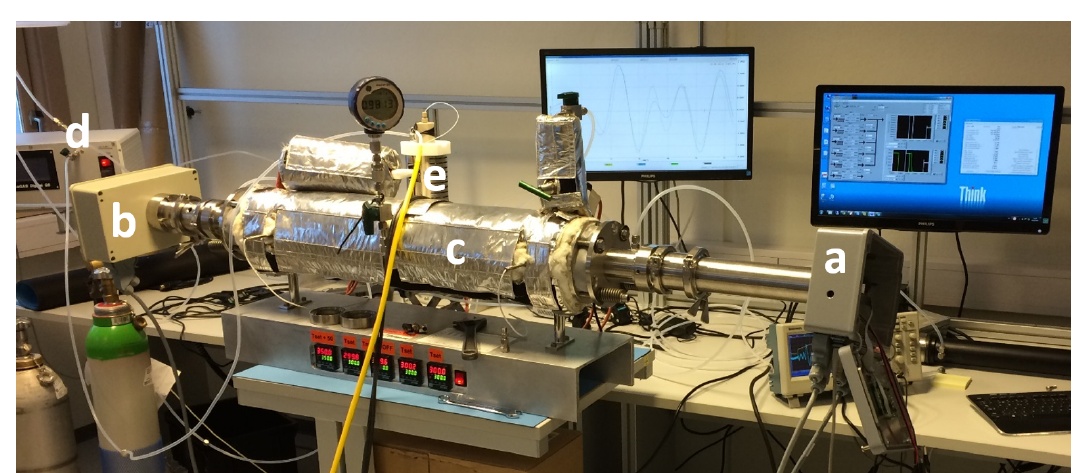
Figure 2. Sulfur dioxide sensor mounted on home-made heated cell: ( a ) transmitter unit; ( b ) receiver unit; ( c ) heated cell; ( d ) gas mixing system and ( e )